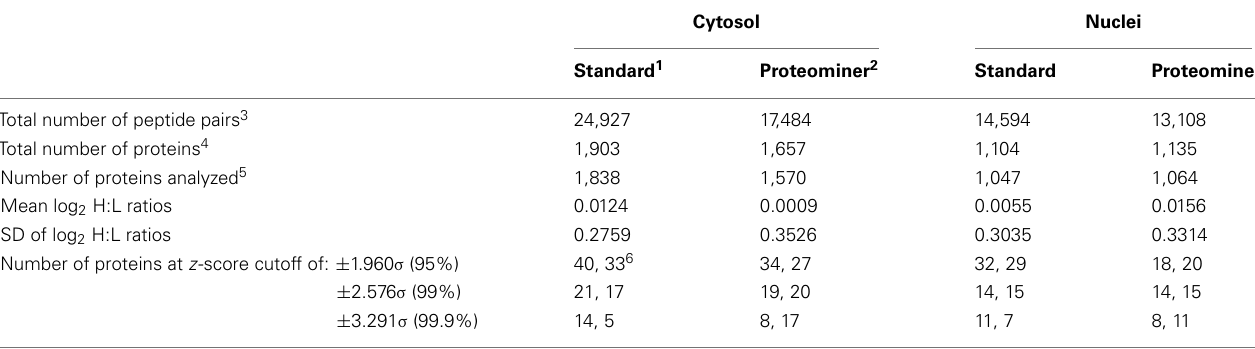
Table 1 | Number of peptides, proteins, log 2 H:L ratio means and SD, and z -scores of SILAC-measured HeLa cell